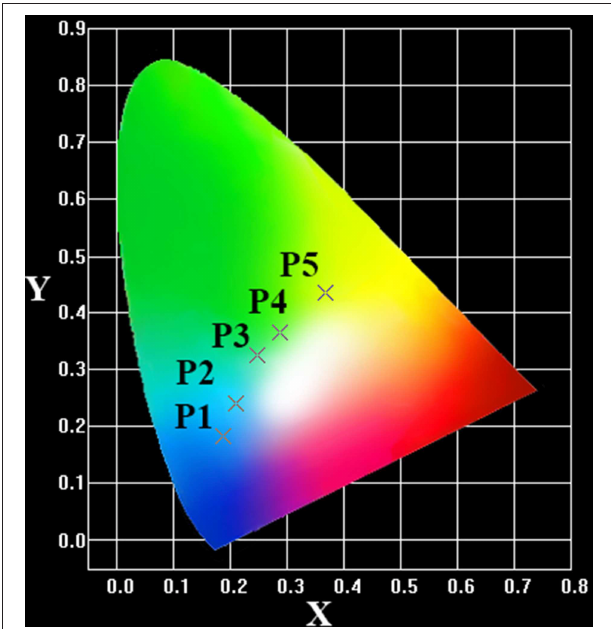
FIGURE 3 | CIE coordinates of samples P1–P5.